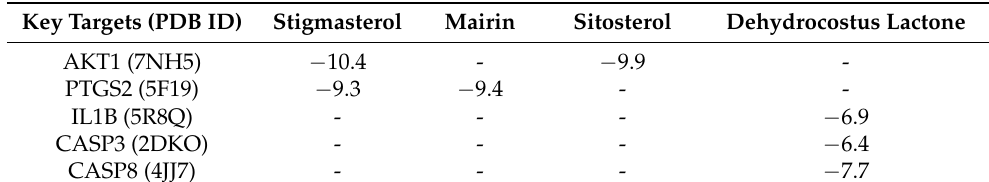
Table 4. Binding energy between the key targets and main ingredients.